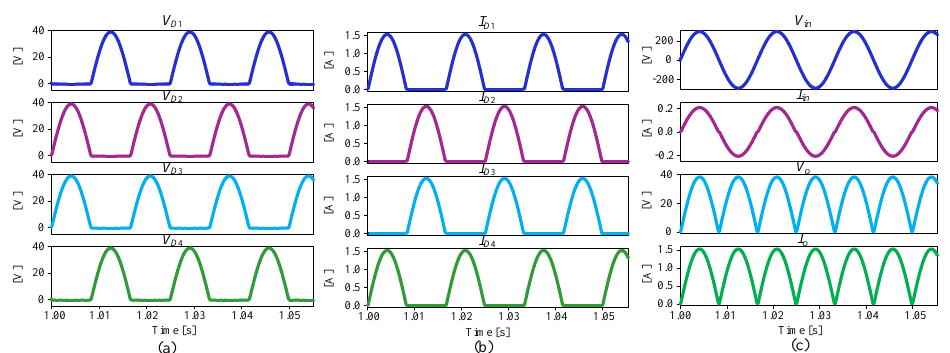
Figure 8. Full-wave bridge rectification.